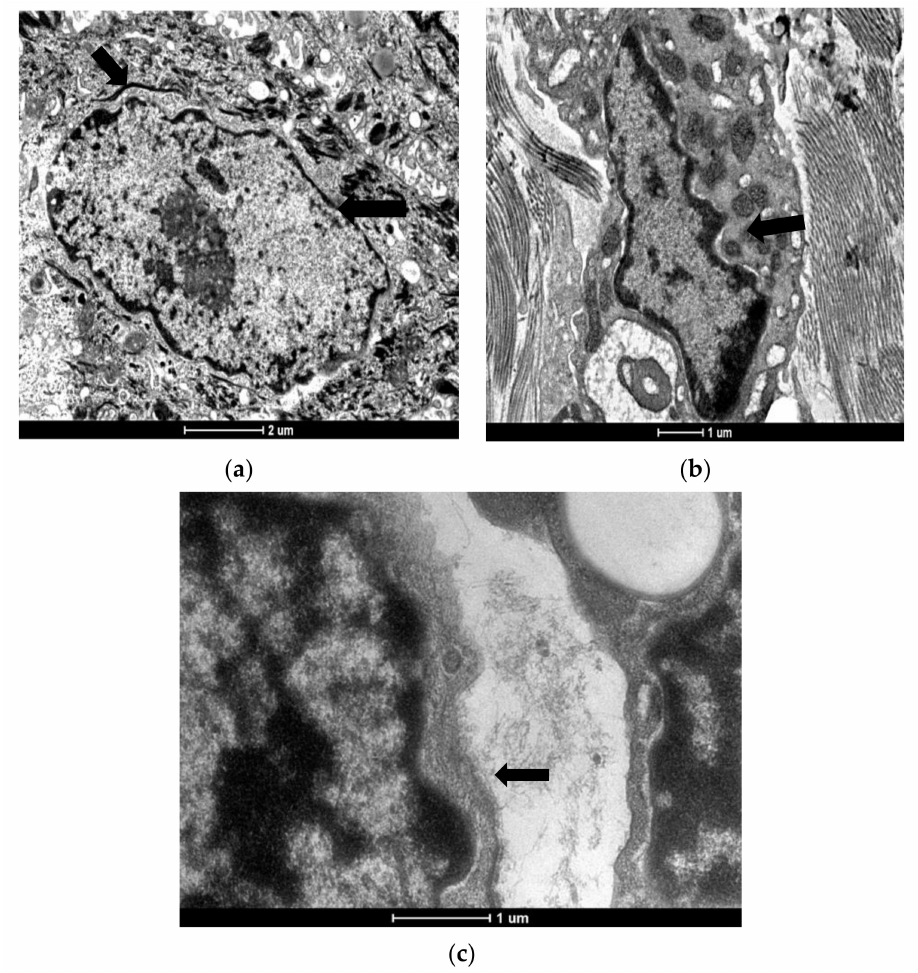
Figure 2. TEM. Keratoacanthoma with mild-moderate dysplasia: ( a ) presence of nuclei in- creased in volume; ( b ) undulating nuclear membrane; and ( c ) discontinuities and invaginations in the